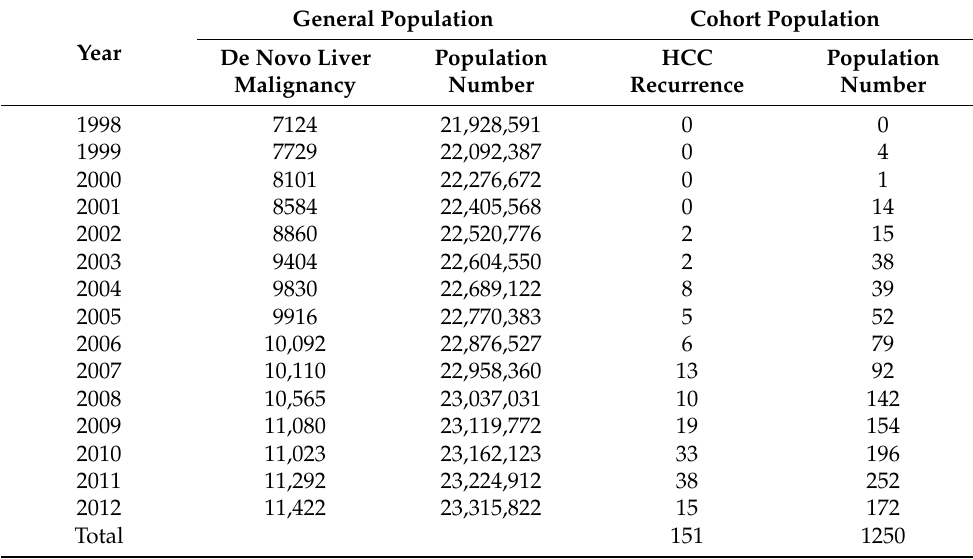
Figure 2. Annual incidence of de novo liver malignancy in general Taiwanese populations from 1998 through 2012. Table 2. Annual Number of Patients with De Novo Liver Malignancy in General Taiwanese Populations, and HCC Recurrence in the LTR Cohort from 1998 Through 2012.